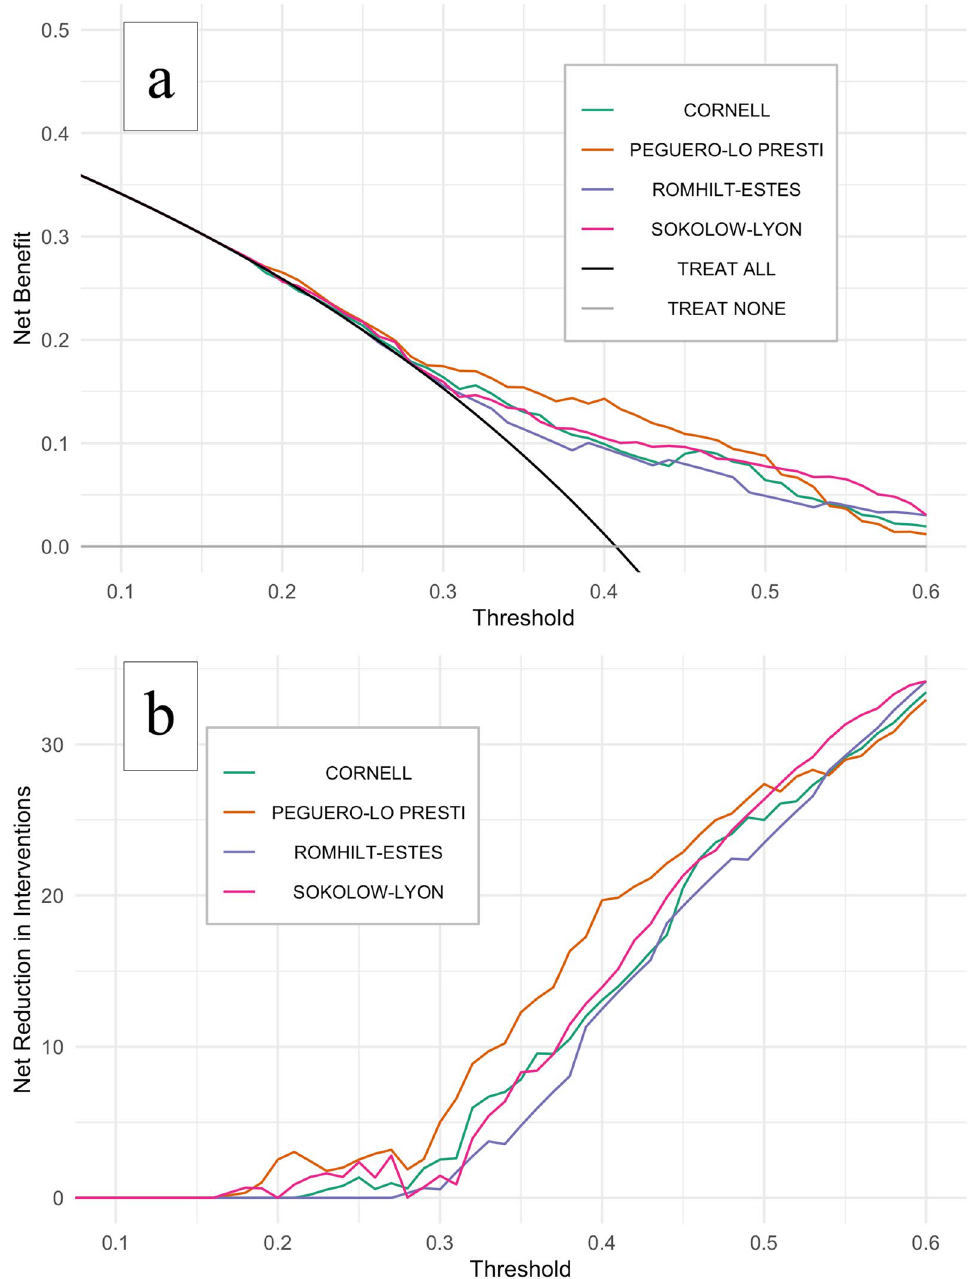
Figure 3. Decision curve analysis for the ECG criteria. Decision curve analysis showing the effect of ECG criteria on the detection of left ventricular hypertrophy as assessed by echocardiogram. Net benefit is plotted against the risk threshold at which the clinician would opt for ordering echocardiogram, compared to strategies of performing echocardiogram to all patients (black line) or none (grey line) ( a ). ( b ) Shows the net reduction in echocardiograms ordered by using different ECG criteria (as shown in the number of unnecessary echocardiograms avoided per 100 patients). Probability threshold range (0.1–0.6) reflect different relative values for harm (performing an echocardiogram in patients without LVH, i.e., false positives) and benefit (identifying a true positive) and were selected a priori to mimic both high (0.1–0.3) and under-resourced (0.3–0.6) theoretical clinical scenarios where elective echocardiogram availability and waiting times are supposed to